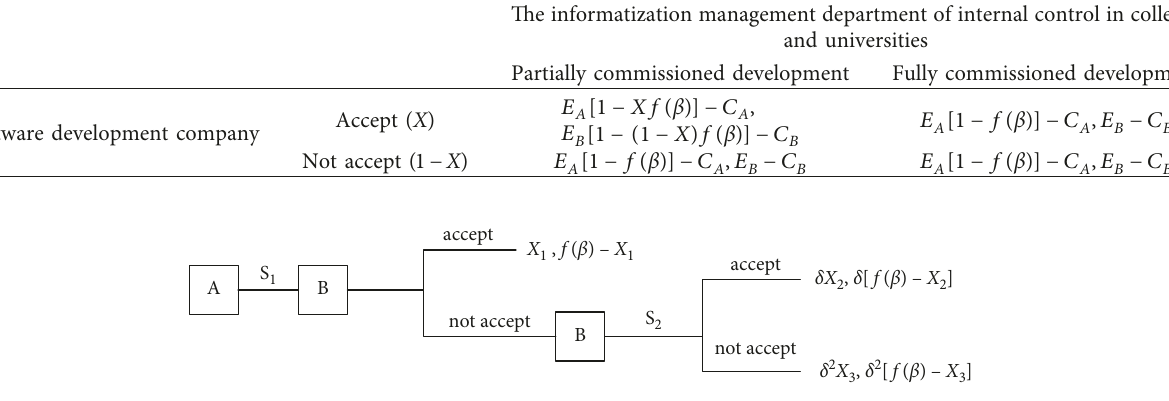
Table 1: Single-game payment matrix based on risk-sharing for A and